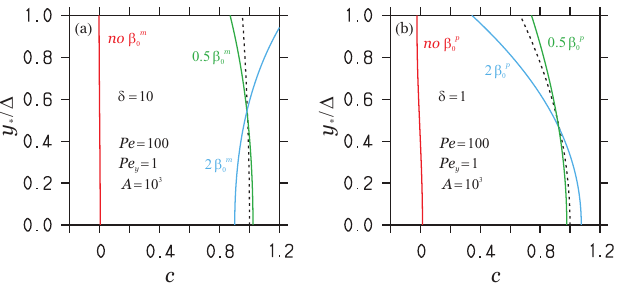
Figure 3. The concentration distribution along y ∗ from y 1 ∗ (lower bound) to y 2 ∗ (upper bound) for reference parameters Pe y = 1, Pe = 10 2 , A = 10 3 , and δ = 10 in ( a ) and δ = 1 in ( b ) at x ∗ = 0 (dashed lines). The red lines refer to the neglect of β m The blue and green lines refer to a modification of β m (2 and